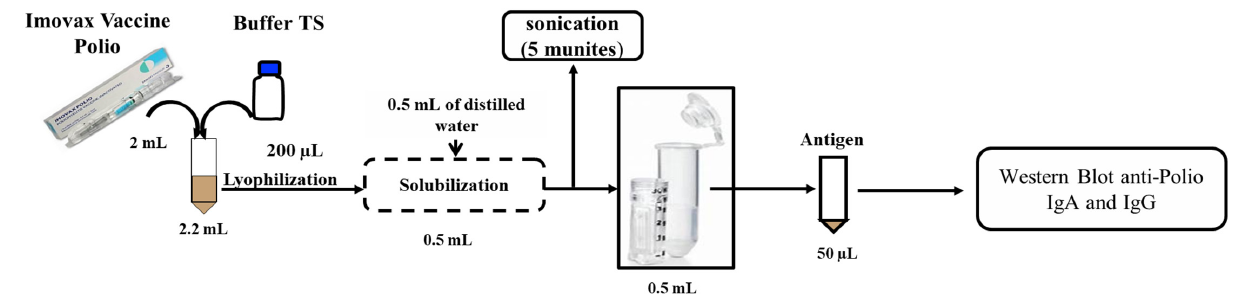
Figure 3. Protocol for the extraction of antigens from the polio vaccine (Imovax ® ) for analysis by western blot. Imovax Polio (2 mL) were treated with 200 µL of the TS lysis buffer (Triton X-100), Lyophilised, and resolubilised in 500 µL distilled water containing 10% TS and fractionated by sonication (5 min) to release the antigen molecules and then concentrated at 10× with a 3 kDa amicon filter.